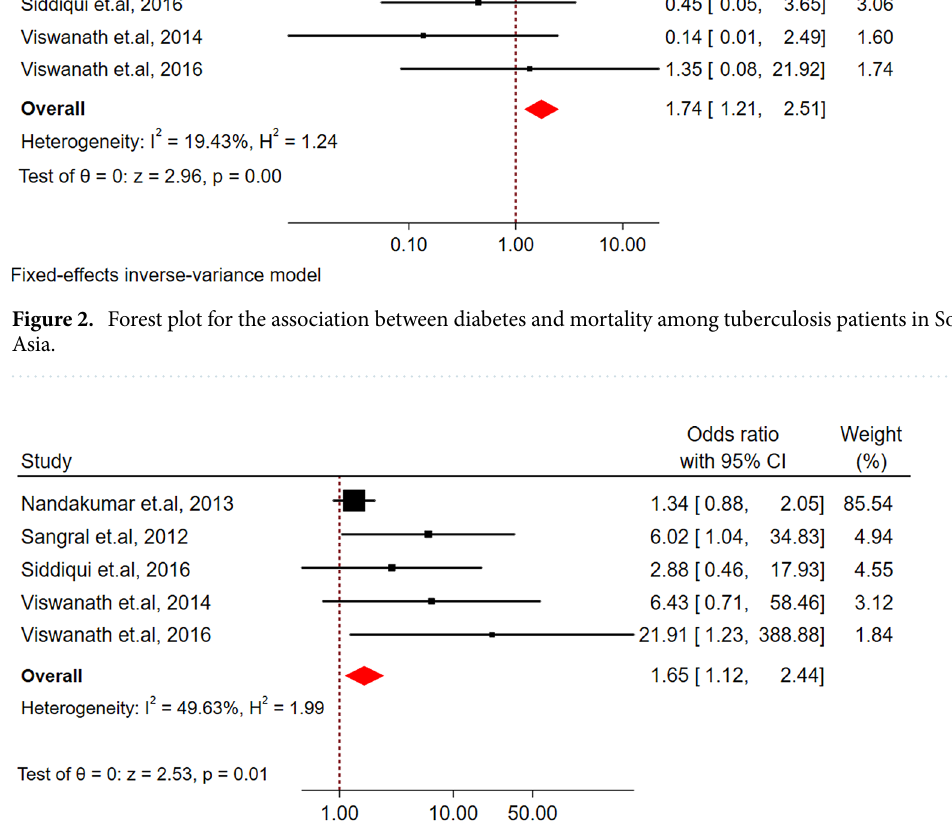
Mortality. The pooled estimates demonstrated that TB patients with diabetes had an approximately two-fold higher risk of mortality as compared with non-diabetic TB patients (Odds ratio (OR) = 1.74, 95% CI 1.21, 2.51;